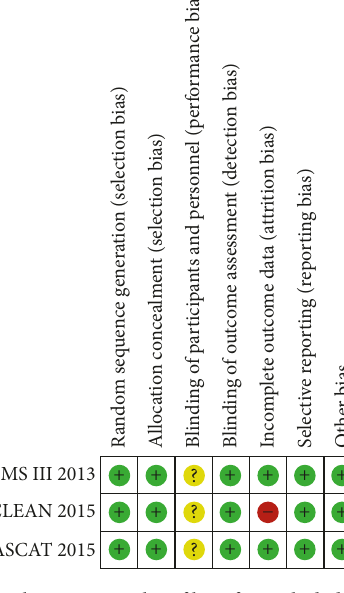
Figure 2: Risk assessment by of bias for included